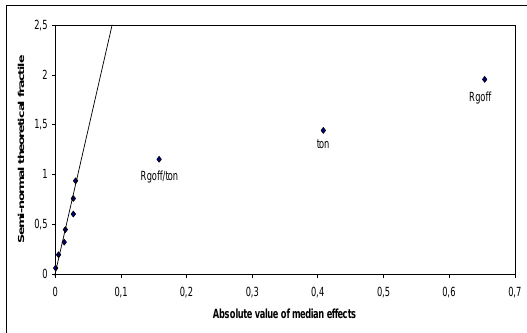
Fig. 2. Daniel’s method applied on dV/dt This method permits to identify the influent factors and first order interactions among the model’s elements. In the graph, all factors which haven’t influence on the response are aligned on a straight line passing by the origin of the graph. Daniel’s method identifies R ton and the first goff, order interaction R /t as influent elements in goff on the model.